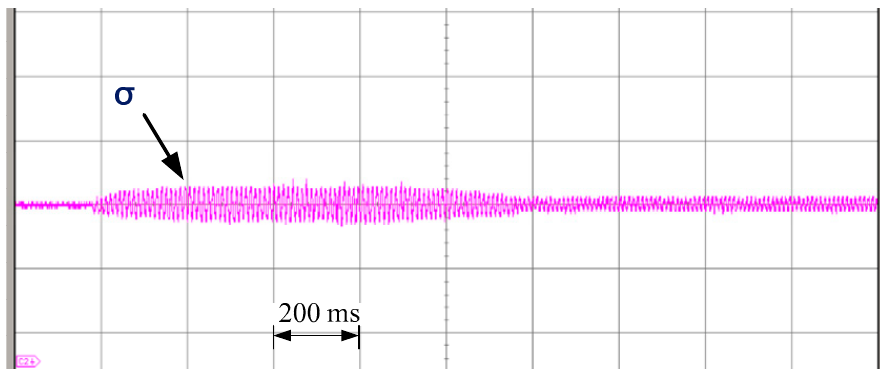
Figure 24. Current response with load.